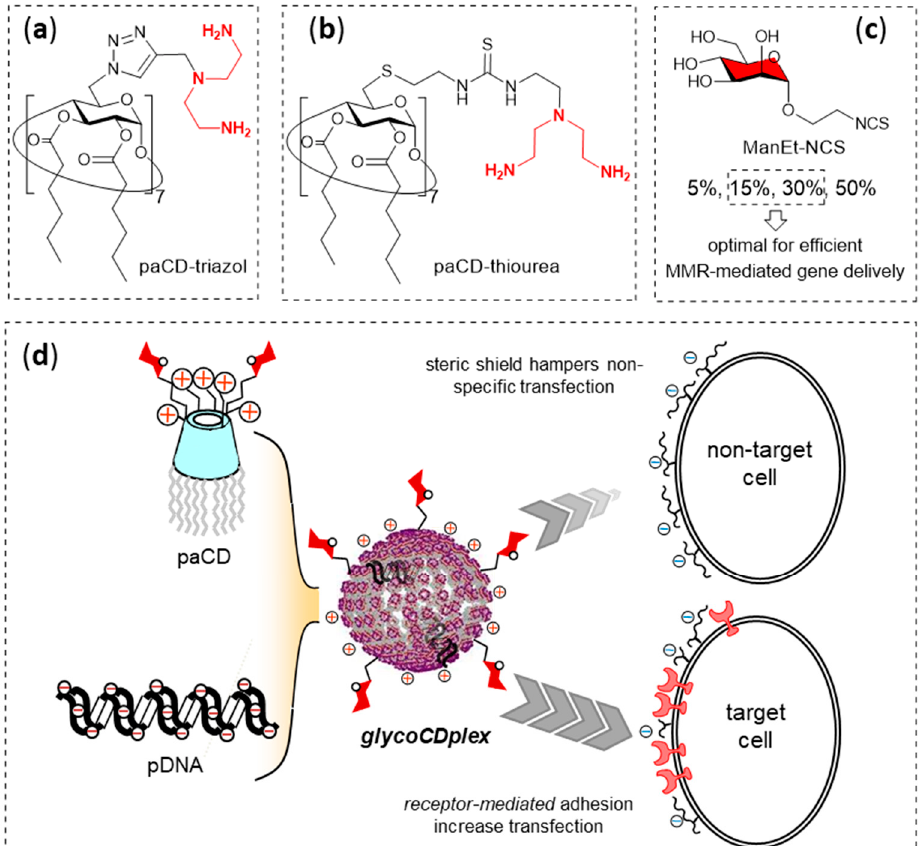
Figure 14. Structures of the paCD-triazol ( a ), paCD-thiourea ( b ) and ManEt-NCS ( c ) precursors used by Di Giorgio, Benito and coworkers [164] to prepare pGaCDs with variable proportions of mannosyl motifs, and a schematic representation of their co-assembly with pDNA to form glycoCDplexes that selectively promoted receptor (MMR)-mediated transfection of the targeted cells (macrophages) ( d ). Adapted with permission from Reference [164]. Copyright 2015 Royal Society of Chemistry. paCD, polycationic amphiphilic cyclodextrin; Man, mannose; pGaCDs, polycationinc glycoamphiphlic cyclodextrins; MMR, macrophage mannose receptor.